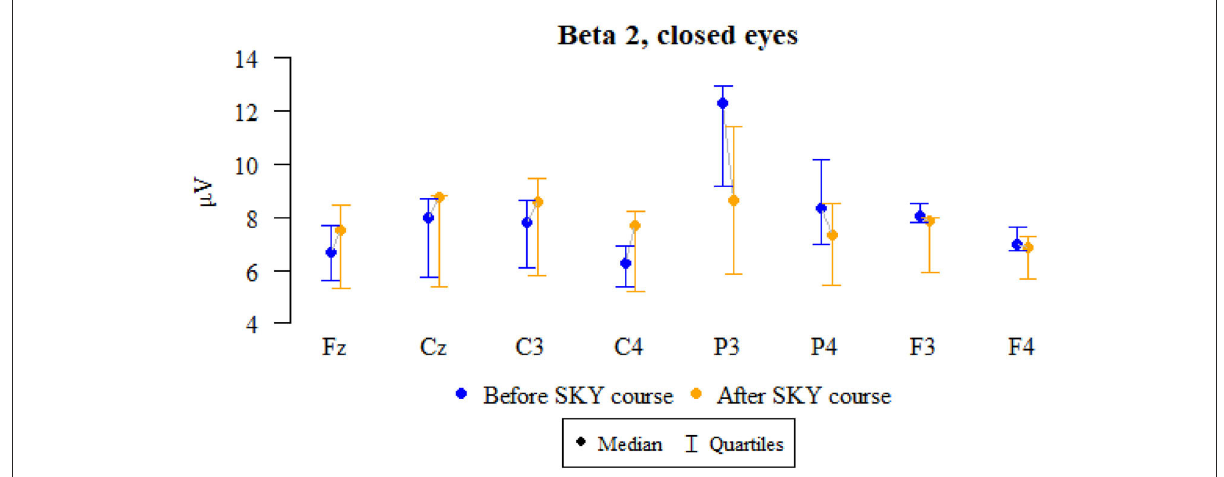
FIGURE6 Graphical comparison of Beta 2 wave amplitudes before the SKY course (first day) and after the whole SKY course (third day) with eyes closed.